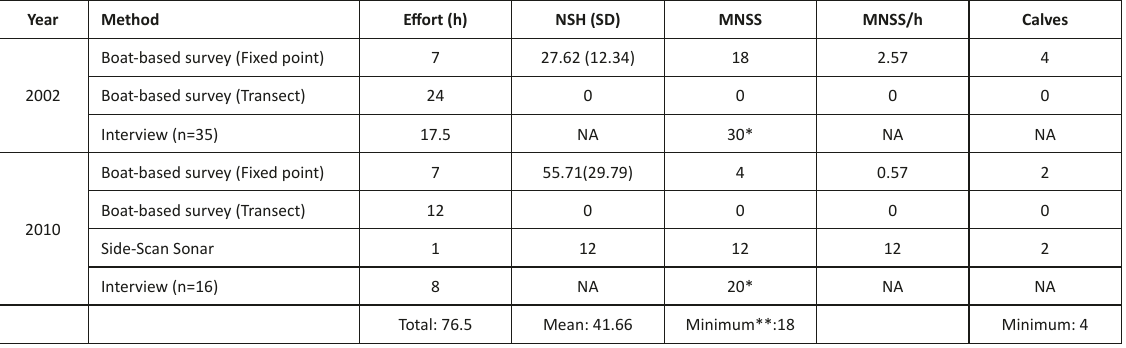
Table 1. Manatee population size in Ciénaga Paredes obtained through different methods. An average of 30 min per interview was